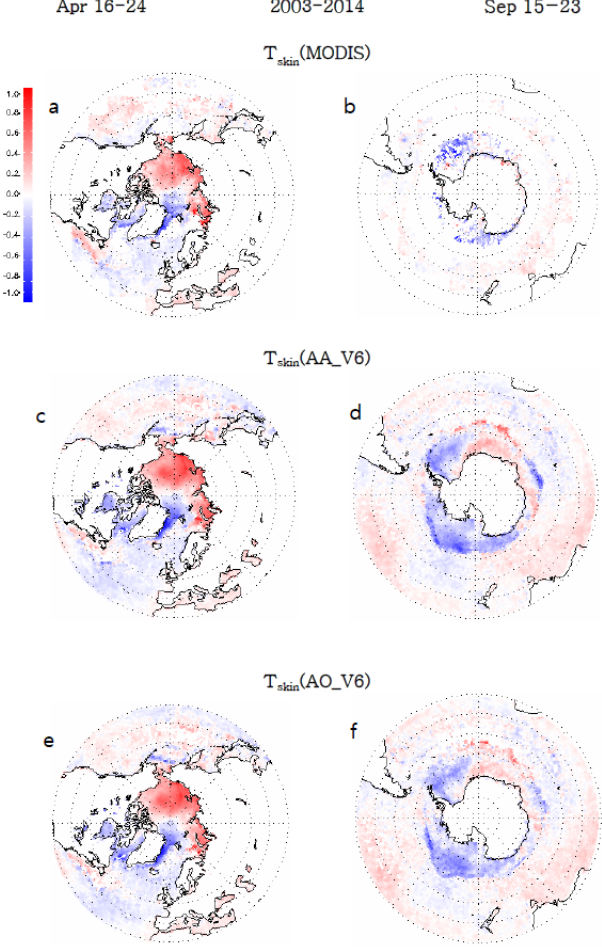
Figure 9. Satellite-derived 9-day anomaly trends (Kyr − 1 ) in a grid box of 1 ◦ × 1 ◦ over the Northern Hemisphere during 16–24 April 2003–2014, for the (a) T skin (MODIS), (c) T skin (AA_V6), and (e) T skin (AO_V6), and over the Southern Hemisphere during 16– 24 September 2003–2014, for the (b) T skin (MODIS), (d) T skin (AA_V6), and (f) T skin